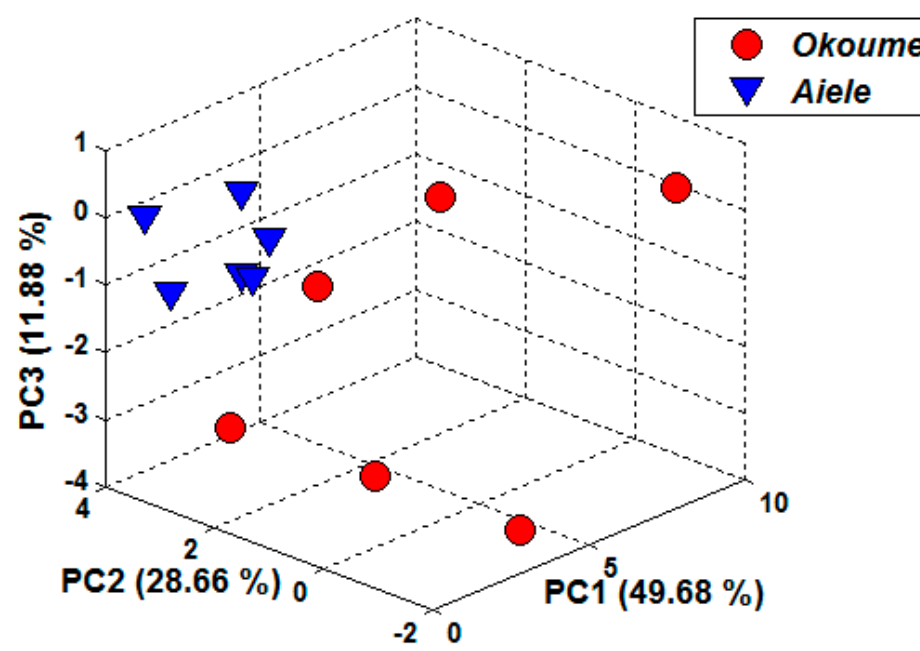
Figure 7. Three-dimensional PCA plot performed on essential oils, namely, okoume and aiele, using the conductance change (Delta-G) of sensors as a response feature.